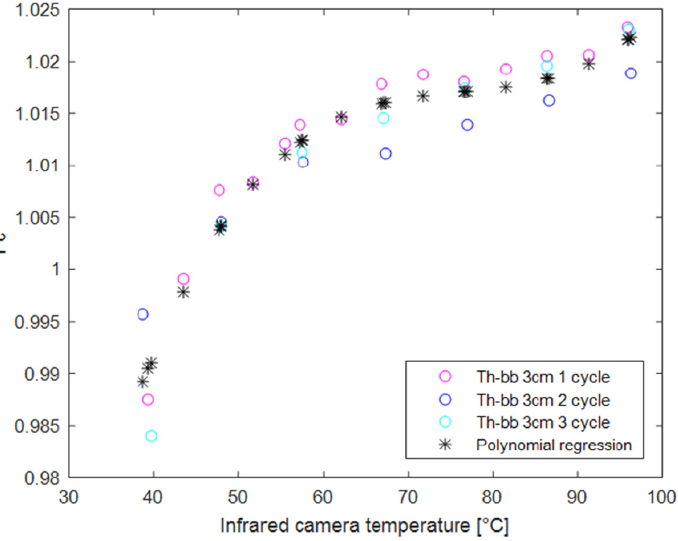
Figure 6. Measured corrective factor Fc during infrared camera calibration vs. T TH in °C. Three different tests (named Th-bb) at a distance of 3 cm are provided.